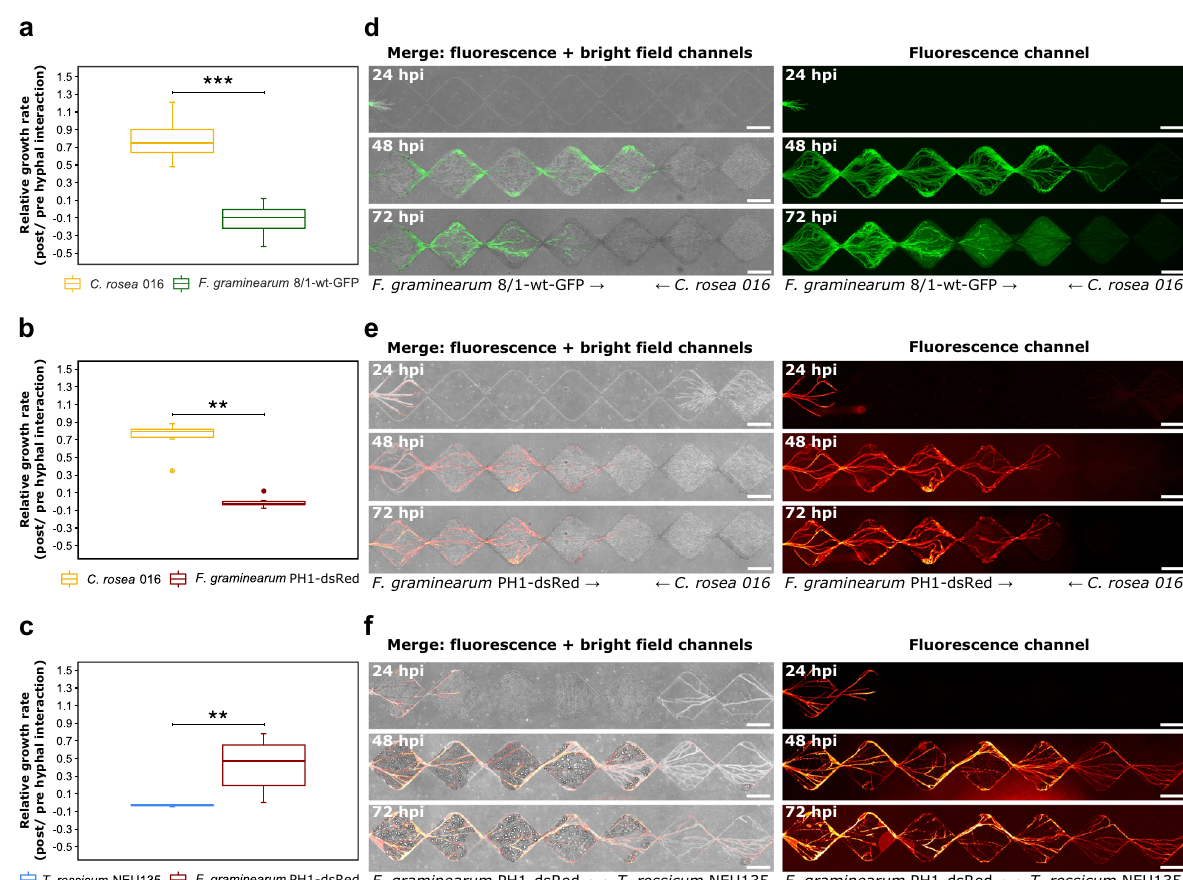
Fig. 2 Differential growth of fungal species in the fungal – fungal interaction device. a – c Boxplots ( n = 6) with the median (bar across box) and 25th to 75th percentiles (box) show the relative growth rate ( = growth rate 24 h post hyphal interaction/growth rate 24 h pre hyphal interaction) for a Clonostachys rosea 016 vs. Fusarium graminearum 8/1-wt-GFP, b C. rosea 016 vs. F. graminearum PH1-dsRed in microchannels fi lled with potato dextrose broth (PDB) and c Trichoderma rossicum NEU135 vs. F. graminearum PH1-dsRed in dry and nutrient-de fi cient microchannels. Upper and lower whiskers represent the largest observation smaller or equal to the upper and lower percentile plus 1.5*interquartile range, respectively. Data points beyond the whisker range are plotted as dots. Signi fi cant differences according to the t test a or the Mann – Whitney U test ( b , c ) are indicated with asterisks for p values < 0.001 (***) and < 0.01 (**). d – f Microscopy image sections (seven diamond segments) taken from time-lapse experiments showing interaction between fungi, speci fi cally d C. rosea 016 vs. F. graminearum 8/1-wt-GFP, e C. rosea 016 vs. F. graminearum PH1-dsRed (microchannel fi lled with PDB) and f T. rossicum NEU135 vs.